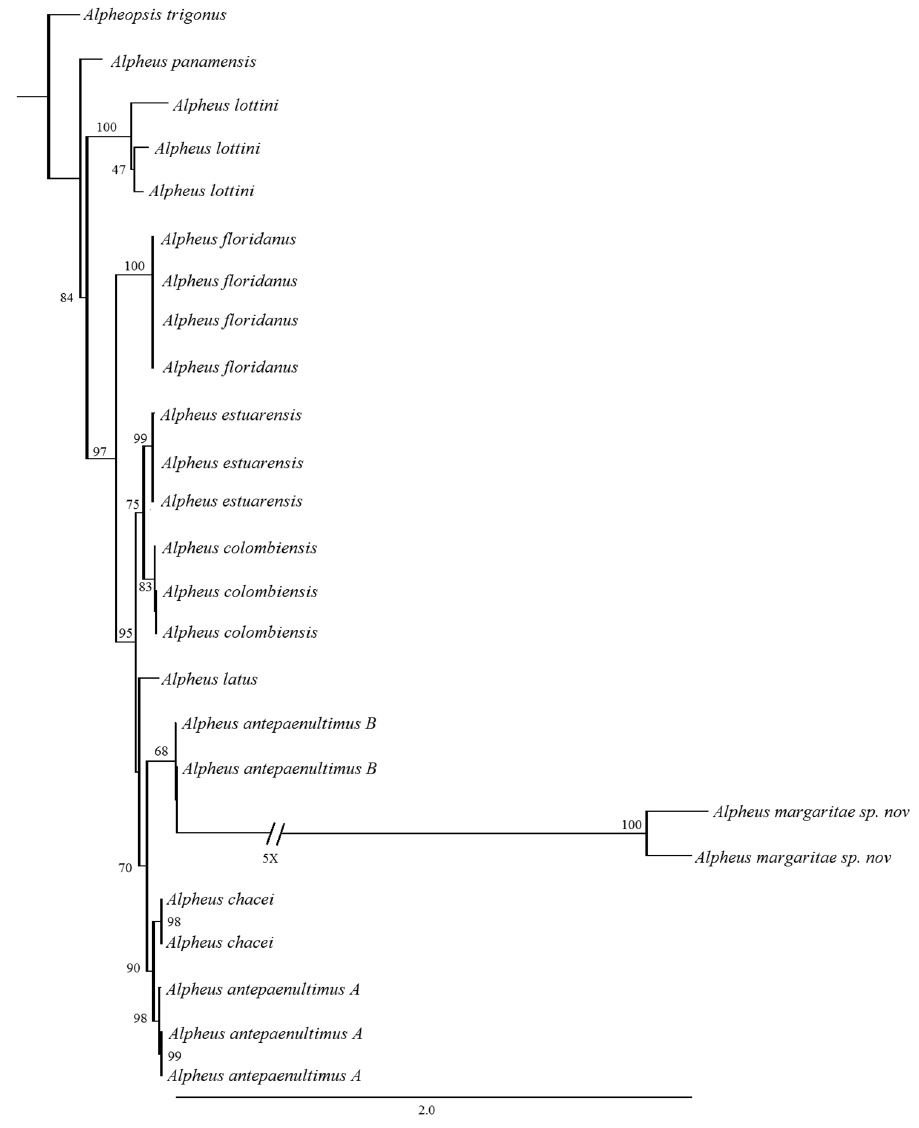
Figure 5. ML tree for Alpheus COI sequences. Numbers above each branch are MP bootstrap values. GeneBank accession numbers of Alpheus chacei , A. antepaenultimus A and A. antepaenultimus B as in Wil- liams et al.